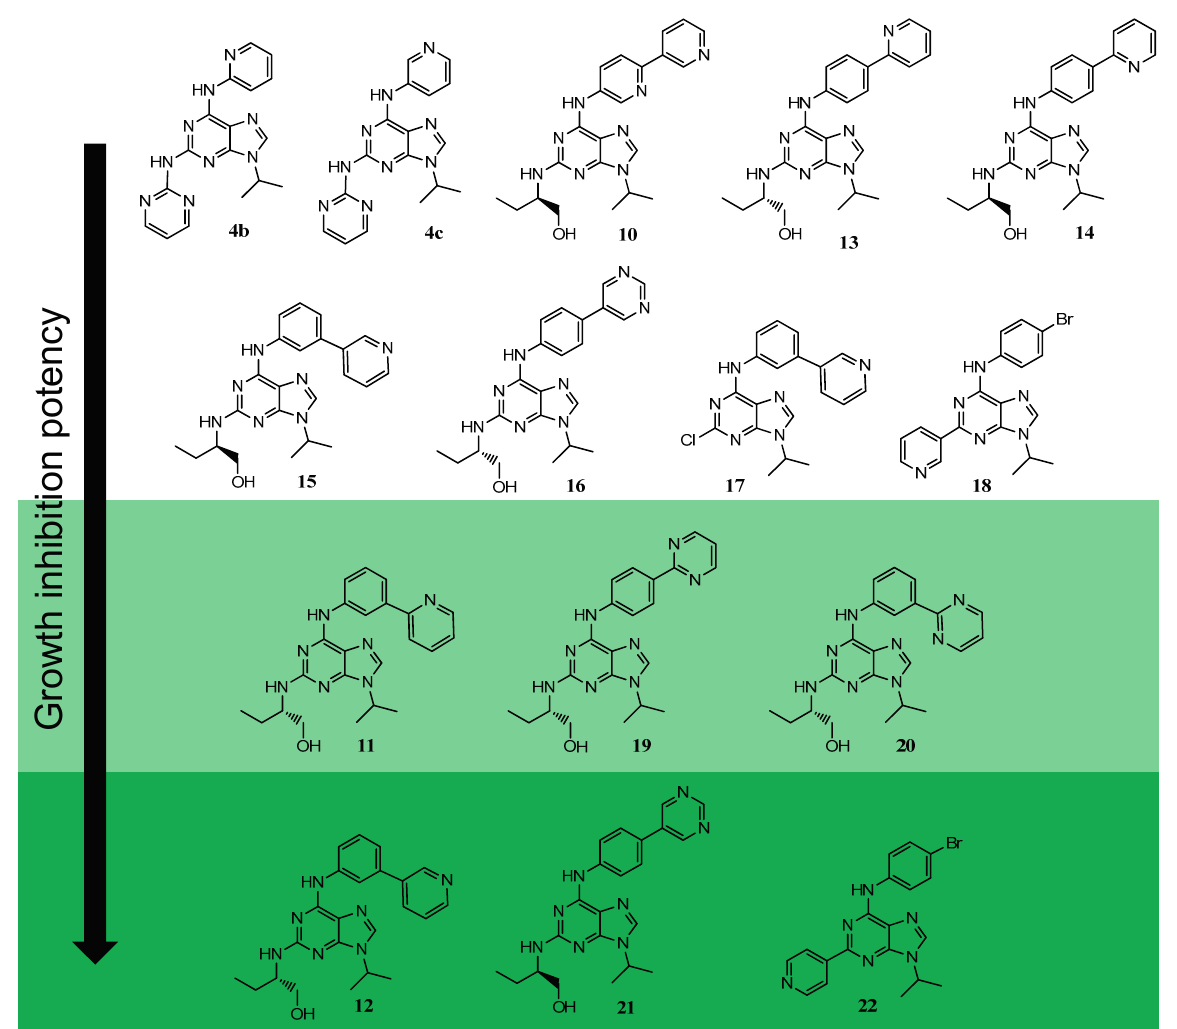
Figure 3. Structures of the 2,6,9-trisubstituted purines screened as P. falciparum growth inhibitors a .